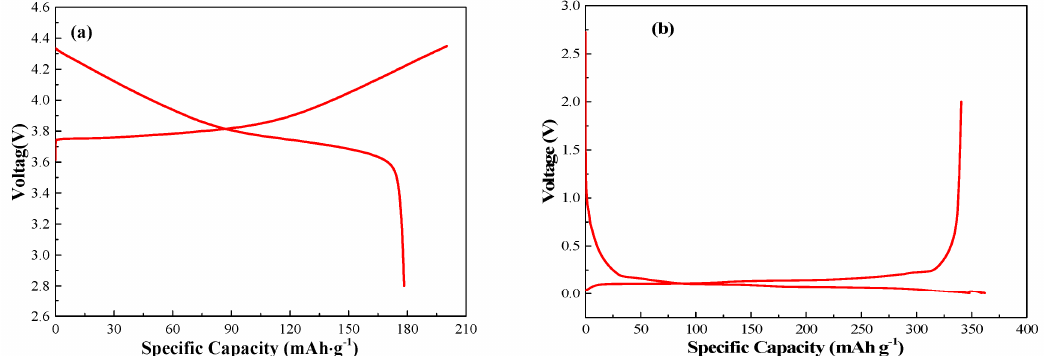
Figure 5. Charge/discharge curves of the ( a ) NCM523 and ( b ) graphite electrodes. Adjust the state of charge of the graphite anode from SOC1 to SOC7 and set